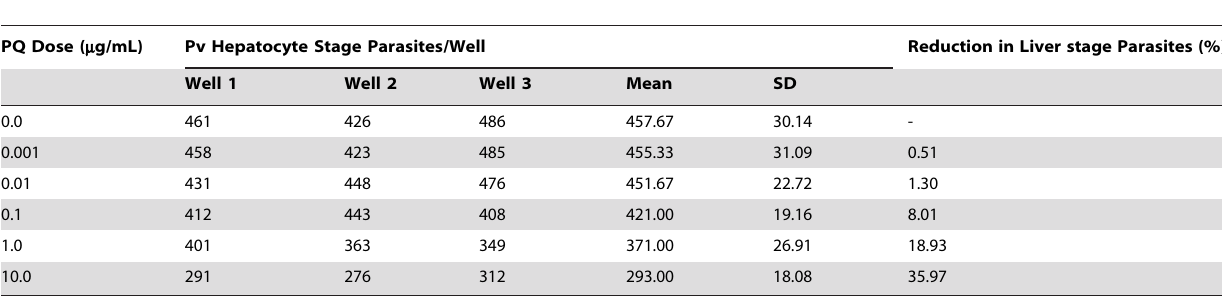
Table 3. Dose dependent effect of primaquine on the development of 3 day hepatocyte stage parasites.